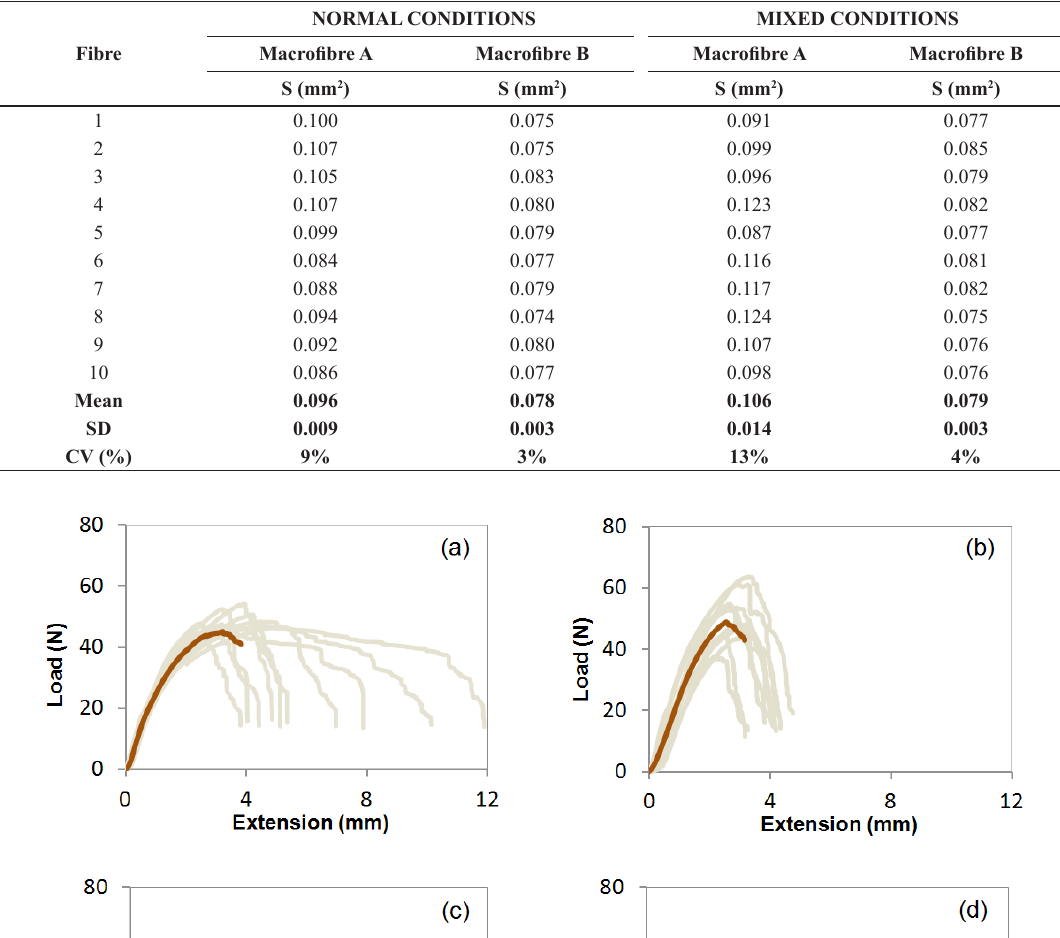
Table 2- Cross-sectional areas of macrofibres, according to the diameter of density method